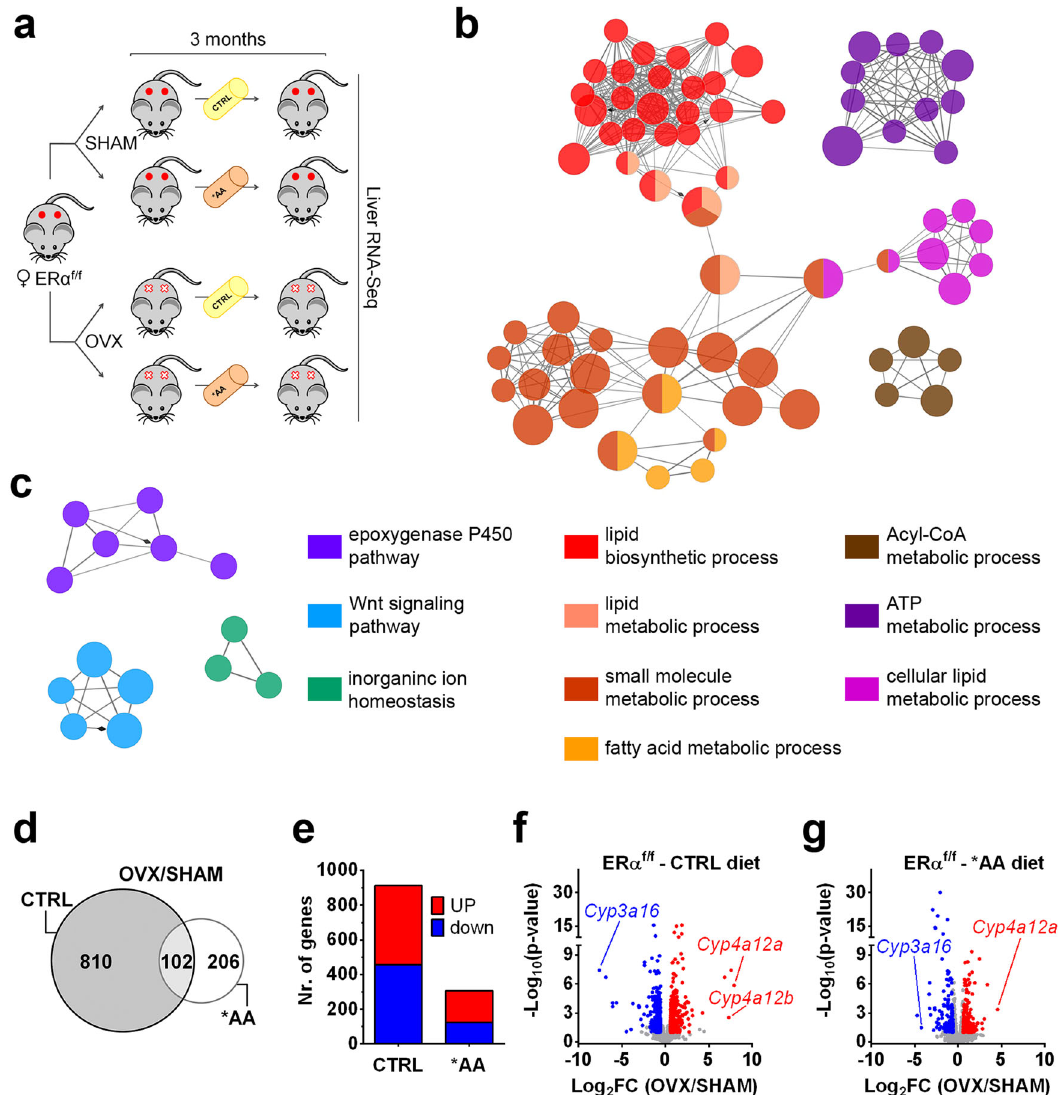
Fig. 1 Dietary EAA/BCAA mitigate the differences in liver transcriptome between SHAM-operated and OVX females. a Experimental design adopted to evaluate the relevance of estrogens in the liver metabolic response to *AA diet. b – c Cluster analysis of the functional networks signi fi cantly up- ( b ) and downregulated ( c ) by OVX in the liver of ER α f/f CTRL-fed females by RNA-Seq analysis ( n = 4). d Venn diagram showing the genes differentially expressed in OVX versus SHAM mice. DEGs were identi fi ed by RNA-Seq ( n = 4) in the liver of SHAM versus OVX ER α f/f females fed with CTRL diet (grey circle, 912 genes) or *AA diet (white circle, 308 genes). e Distribution of genes up- and downregulated by OVX measured by RNA-Seq analysis ( n = 4) in the liver of ER α f/f females fed with CTRL or *AA diet. f – g Volcano plot of liver DEGs measured by RNA-Seq ( n = 4) in SHAM and OVX ER α f/f females fed with CTRL ( f ) or *AA ( g ) diet. OVX/SHAM ratio of gene expression is shown on the X axis as Log 2 FC and signi fi cance is displayed on the Y axis as − Log 10 padj. Genes signi fi cantly up- and downregulated with |FC| > 1.5 and padj < 0.1 (two-tailed Student ’ s t -test) by OVX are colored in red and blue, respectively; genes not differentially expressed are displayed in grey. Cyp3a16 , Cytochrome P450 3A16; Cyp4a12a , Cytochrome P450 4A12A; Cyp4a12b , Cytochrome P450 4A12B. Source data are provided in 56 ; processed data are provided as a Source Data fi